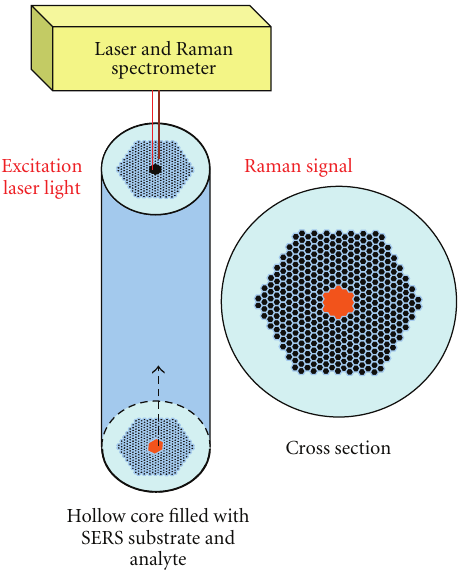
Figure 4: Schematic of the LCPCF SERS sensor and its cross- sectional view. The spectrometer above the surface contains a CCD detector, a monochromator, and electronics for data